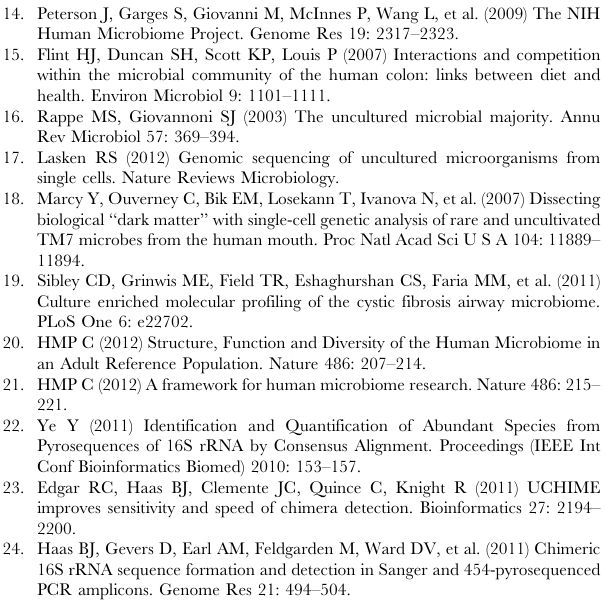
Figure S1 The UCHIME ref score, against GOLD database, versus the fraction of reads chimeric in each OTU for each consensus sequence. Left panel: V1–V3; right panel V3–V5. Gray indicates a consensus sequence called chimeric by UCHIME against the GOLD database. Figure S2 UCHIME Ref scores versus UCHIME de novo scores for V1–V3 (left panel) and V3–V5 (right panel). Colors indicate whether the consensus sequence was called chimeric by just UCHIME de novo (red), just UCHIME ref to the GOLD database (gray), both methods (blue) or neither method (black). Figure S3 Silva percent identity versus max UCHIME score (max of UCHIME ref and UCHIME de novo) for V1–V3 (left panel) and V3–V5 (right panel). Colors indicate whether the consensus sequence was called chimeric by just UCHIME de novo (red), just UCHIME ref to the GOLD database (gray), both methods (blue) or neither method (black).